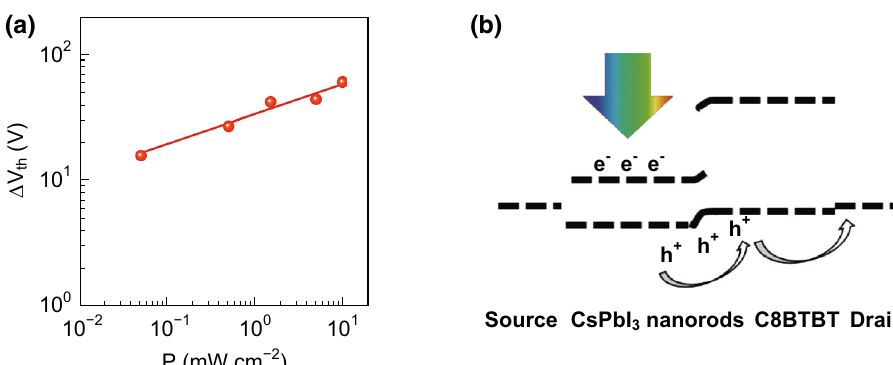
Fig. 3 a Shift of the threshold voltage of the hybrid phototransistor as a function of the illumination power density. b Schematic of the photo- generated carrier transport in the hybrid phototransistor under